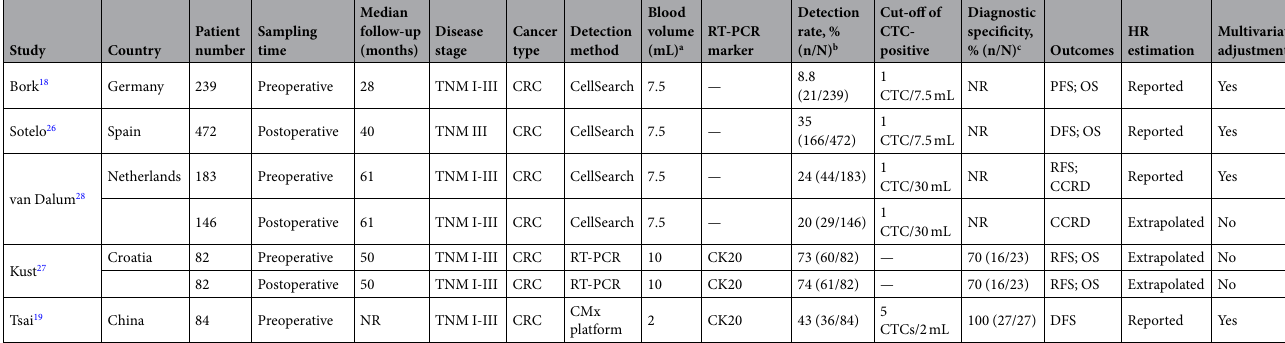
Table 1. Characteristics of studies included in this meta-analysis. Abbreviations: NR, not reported; M0, non- metastasis; M1, metastasis; RT-PCR, reverse transcriptase polymerase chain reaction; OS, overall survival; DFS, disease-free survival; RFS, recurrence-free survival; CRS, cancer-related survival; CCRD, colon cancer related death. a It referred to the sample blood volume used for CTC isolation in each study. b It referred to the number of CTC-positive patients (n) per total number of patients (N) included in each study. c It referred to the number of CTC-negative subjects (n) per total number of healthy controls (N) included in each study. d The study of Lu (2013) was removed in the overall analysis because it had overlapping cases with the study of Lu (2011), but it was included in the subgroup analysis based on cancer